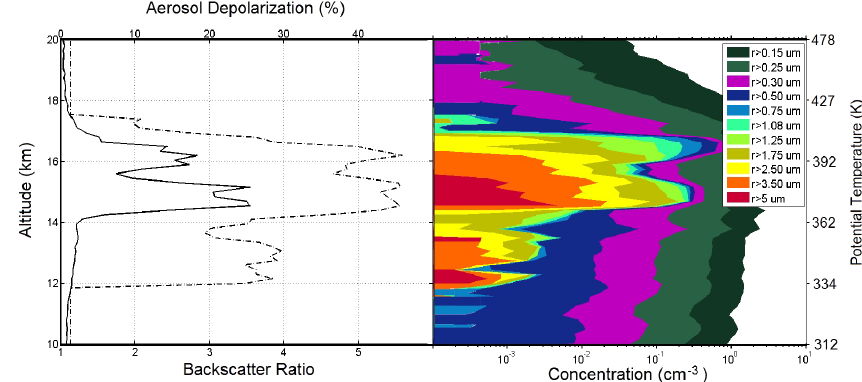
Figure 1. Left panel: altitude profiles of backscatter (solid line) and aerosol depolarization (dashed line) ratio measured by lidar. Right panel: altitude profiles of optical particle counter integrated size distributions; the colors indicate different lower diameter thresholds from 0.15 to 5µm, as reported in the legend.